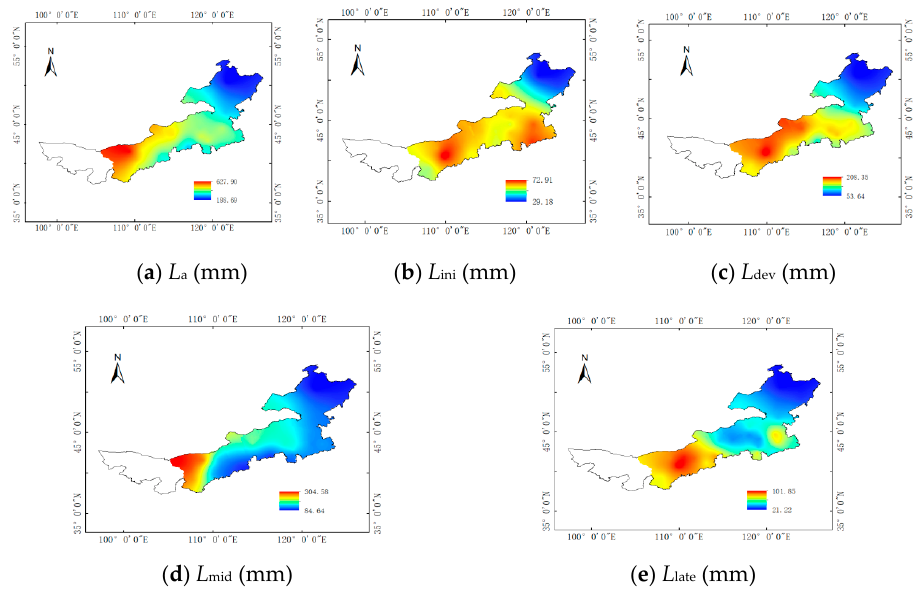
Figure 7. Spatial variation characteristics of I r during the entire growth period ( a ), early growth period ( b ), rapid growth period ( c ), middle growth period ( d ), and end growth period ( e ) of maize from 1959 to 2018.